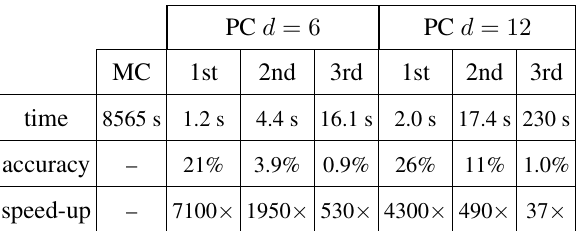
Tab. 4 collects the main figures concerning the effi- ciency and the accuracy of the proposed method. A signifi- cant speed-up of 37 × is achieved even when up to 12 vari- ables are included. For both scenarios, third-order PCEs are needed to approach the MC accuracy. For this example, the SGM implementation only executes for d = 6 and a first-order PCE, for which it takes 14